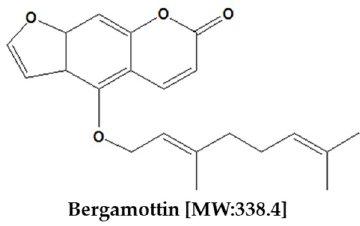
Figure 1. The chemical structure of bergamottin.